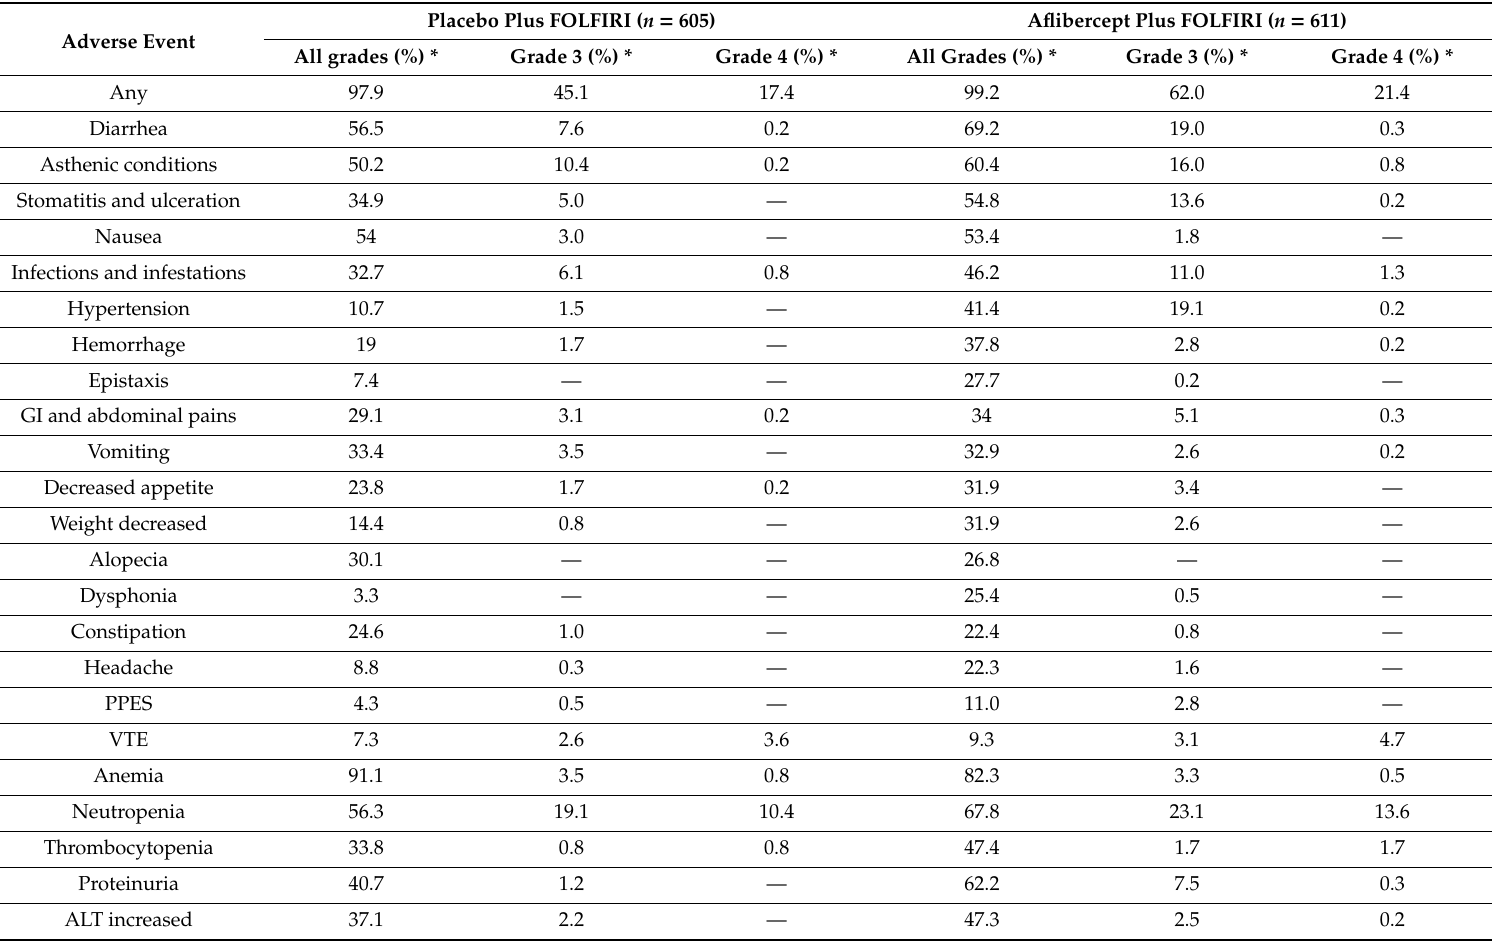
Table 1. Summary of adverse events (any grade) ≥ 5% in the VELOUR trial of placebo plus FOLFIRI vs aflibercept plus FOLFIRI [11]. Adverse